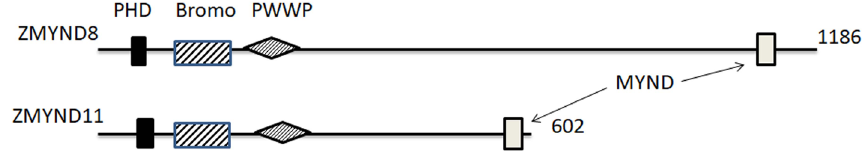
Fig. 3 The scheme of motif composition of two ZMYND proteins, RACK7/ZMYND8 and BS69/ZMYND11. They have identical conserved domains with similar activities in histone interactions and genomic reading, and hence implicate in carcinogenesis. The number defines the position of the full length of the molecules with number of amino acid residues, based on individual entry of uniprot. Org, retrieved on Sep- tember 28, 2020. It has been reported that MYND domain on the C-terminus of ZMYND8 possesses the ability to bind a demethylase, JARID 1D